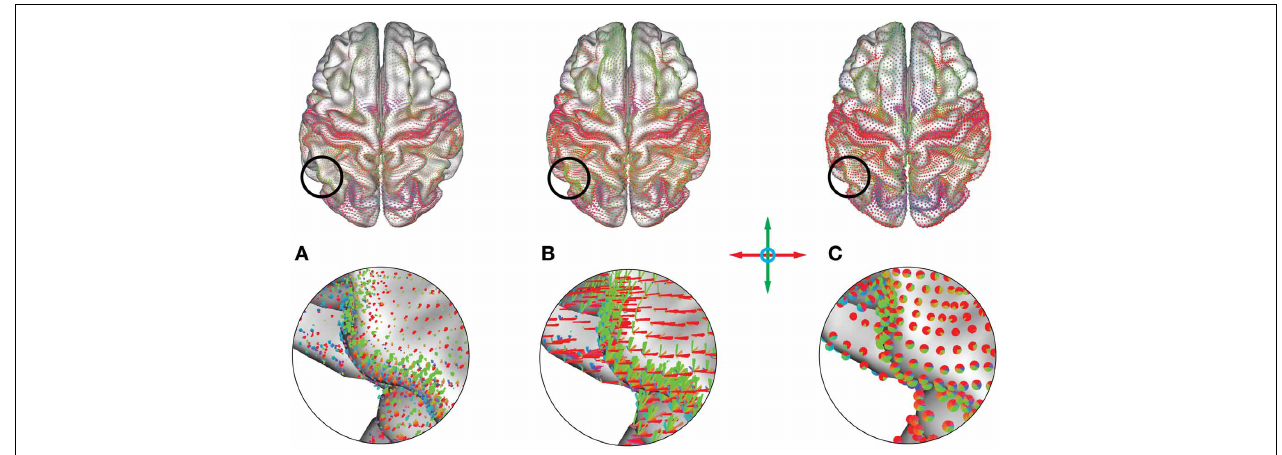
FIGURE 12 | (A) Point, (B) vector and (C) pie chart glyphs for a whole-brain average functional connectivity dataset (threshold: r > 0 . 5, minimum length = 20mm). Colors represent orientation of the underlying connections. The motor network presents as a red belt due